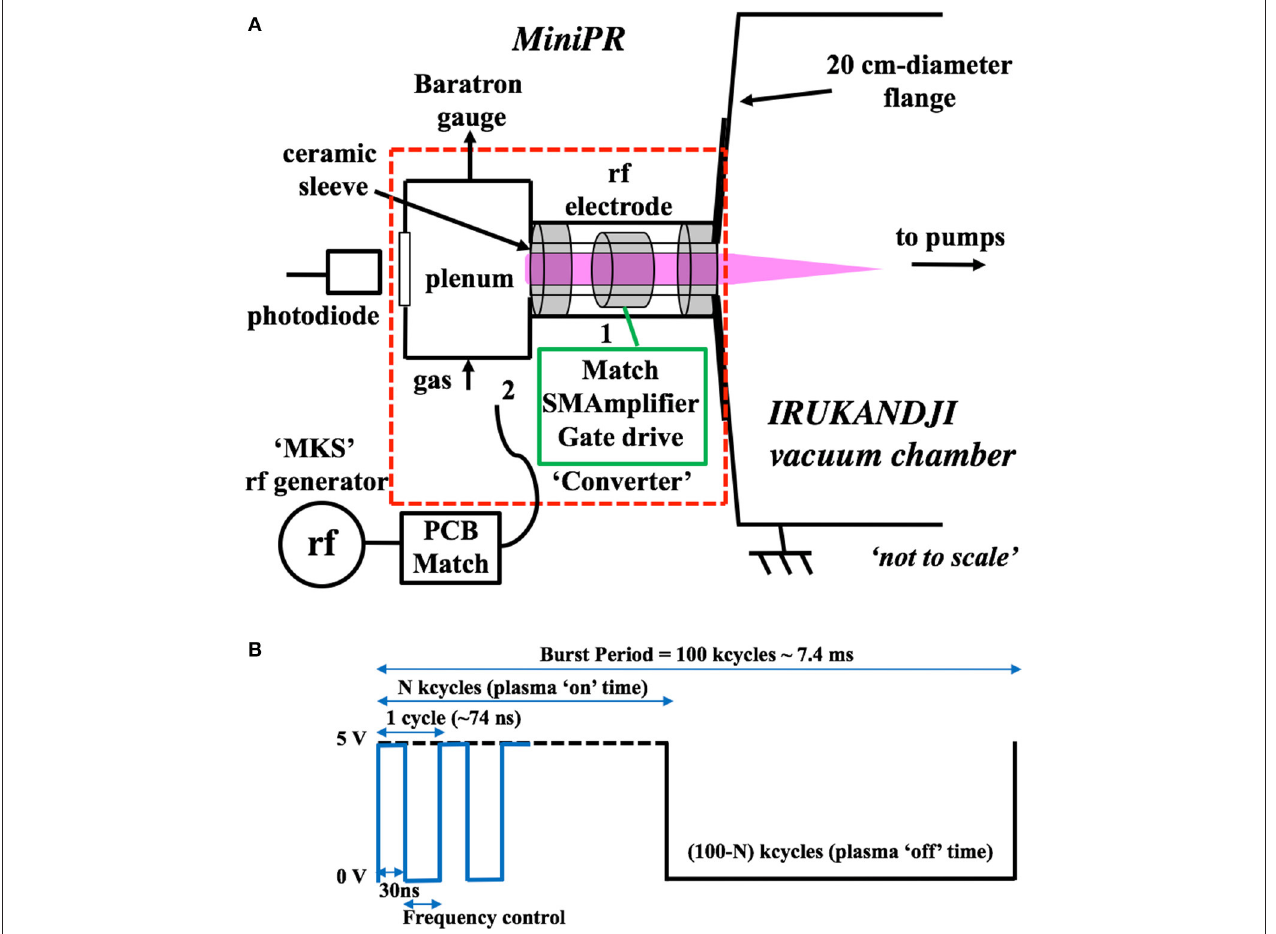
FIGURE 1 | (A) Schematic of the MiniPR electrothermal radiofrequency plasma thruster body mounted onto the IRUKANDJI vacuum chamber flange with the two radiofrequency power systems external to vacuum and connected to the rf electrode: system (1) is the Converter switch mode amplifier (SMAmplifier) prototype with impedance matching network (Match) integrated on a PCB and system (2) is a variable frequency commercial MKS rf generator feeding a custom-made impedance matching network (PCB Match); (B) Signal applied to the gate drive board (Gate drive) feeding the switch mode amplifier MOSFET. The dotted red line square